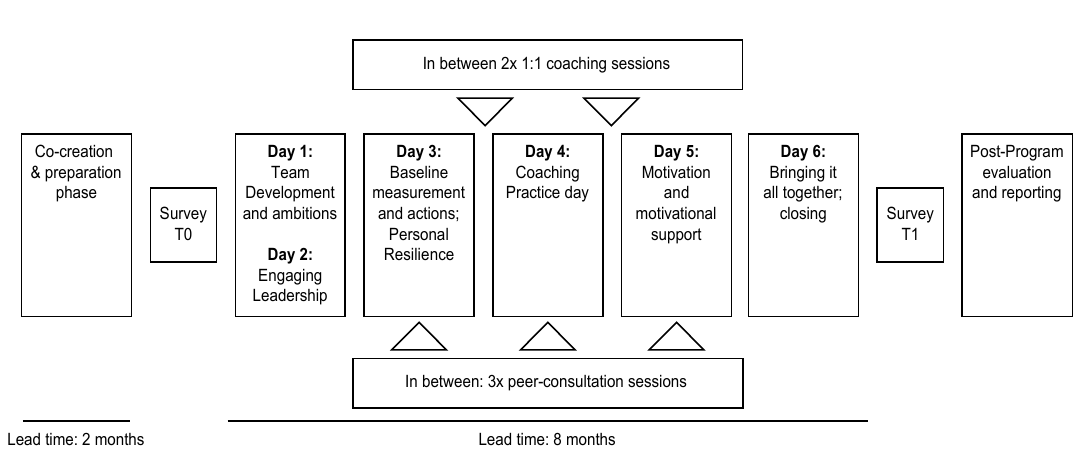
Figure 1. This Figure displays the program’s structure and content, starting with a two-month preparation and co-creation phase in which the goals and parameters for success were defined between the global leadership team of the department and the local leadership team that would participate in the program. Then, the pre-test survey was sent out to establish baseline (T0). The training intervention consisted of 6 training days with a 6–8-week interval. The first training session lasted two consecutive days. In between, three peer consultation sessions and two one-on-one coaching sessions were offered. The total duration was eight months, after which the post-test measurement (T1) was conducted. After the program had ended, business measures continued to measure